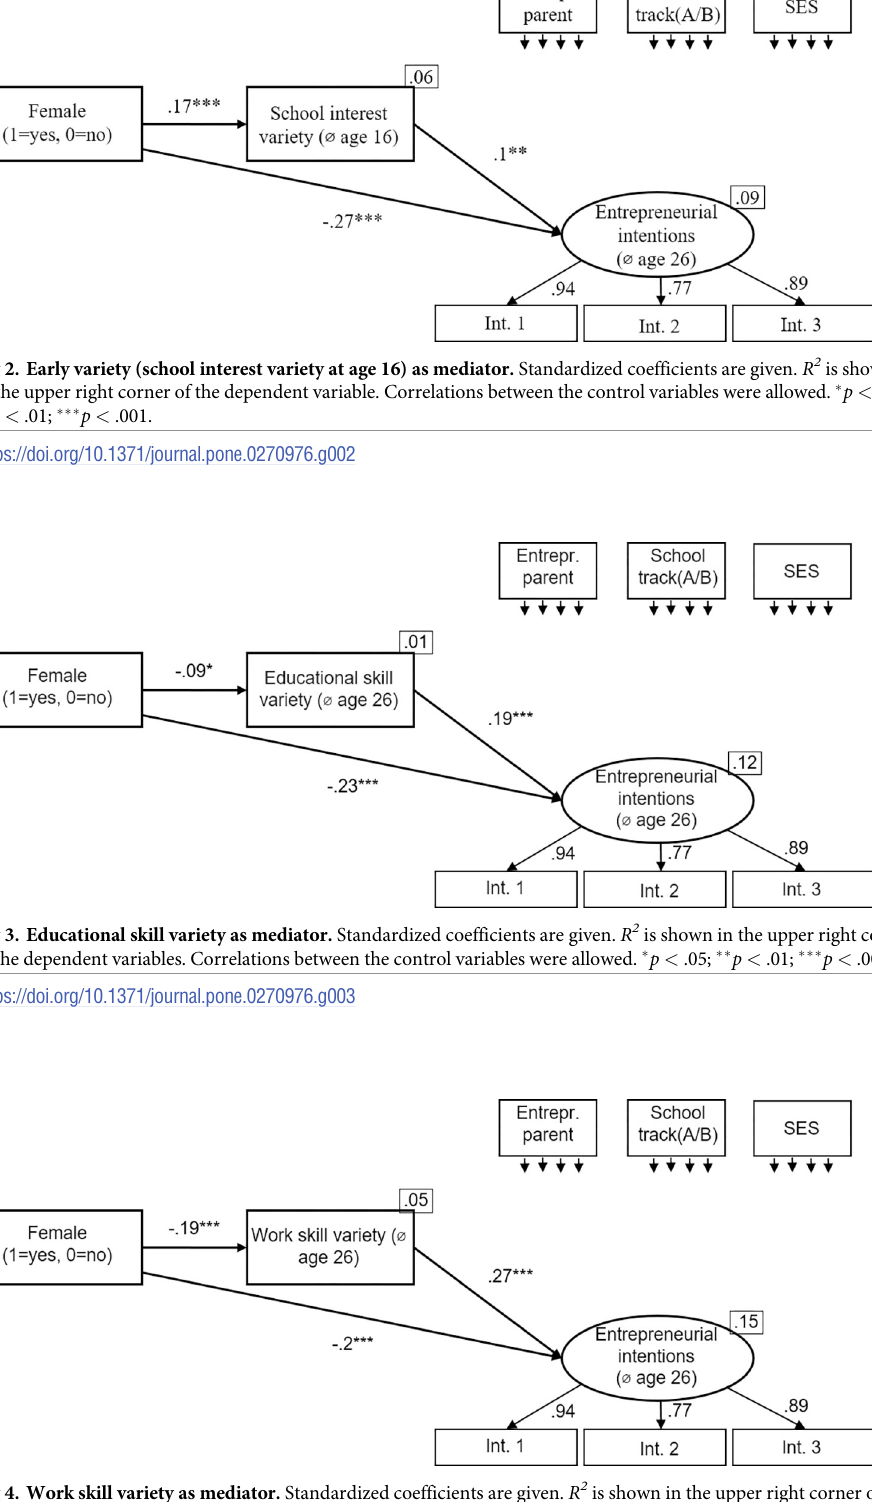
Fig 4. Work skill variety as mediator. Standardized coefficients are given. R 2 is shown in the upper right corner of the dependent variables. Correlations between the control variables were allowed. � p < .05; �� p < .01; ��� p < .001.